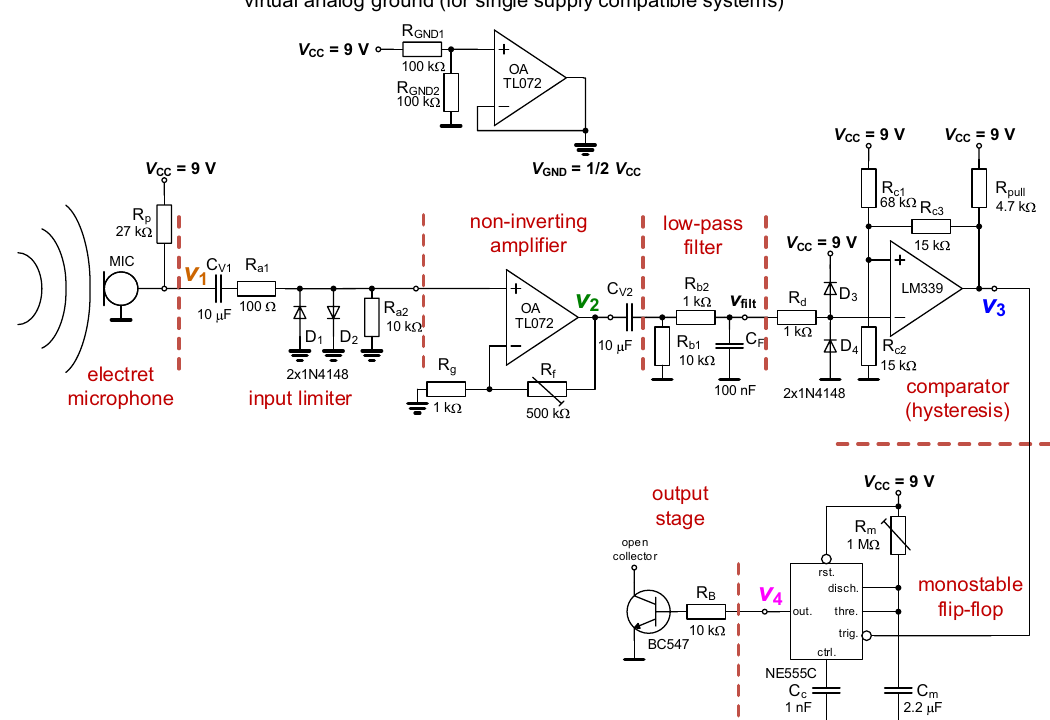
Figure 2. The complete circuit topology of the sensing system designed for initialization of acoustic impact event.